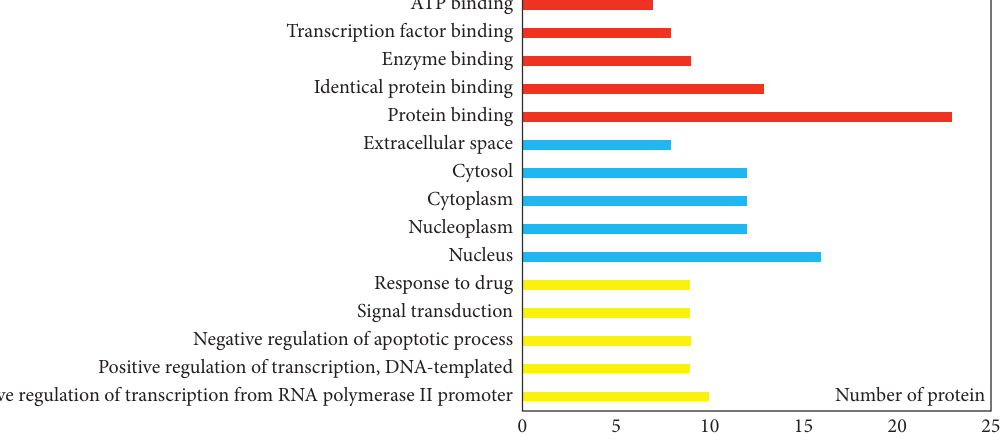
Figure 3: GO analysis by DAVID: red represents the biological process, yellow represents the cellular component, green represents the molecular function.